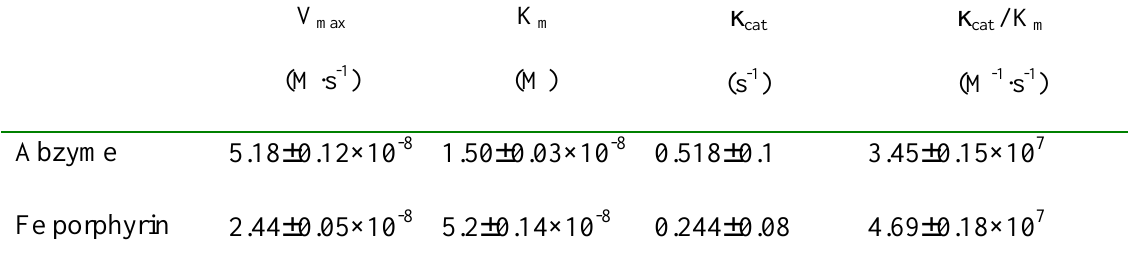
Table 1. Kinetic constants of abzyme and Fe